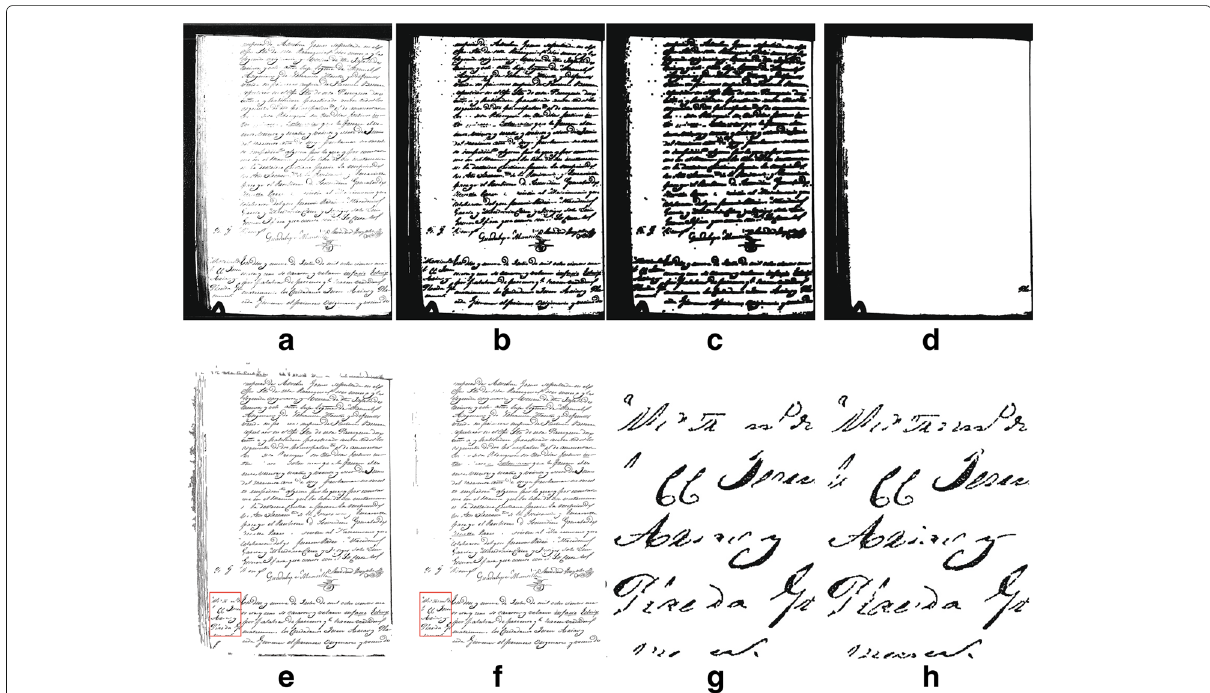
Fig. 4 Results of the proposed binarization method: a Otsu’s binarization result of Fig. 2a. b Dilation result with filter size = 5. c Dilation result with filter size = 10. d Detected non-page regions from b . e Binarization result without non-page detection. f Binarization result with non-page detection. g Zoom-in of e . h Zoom-in of